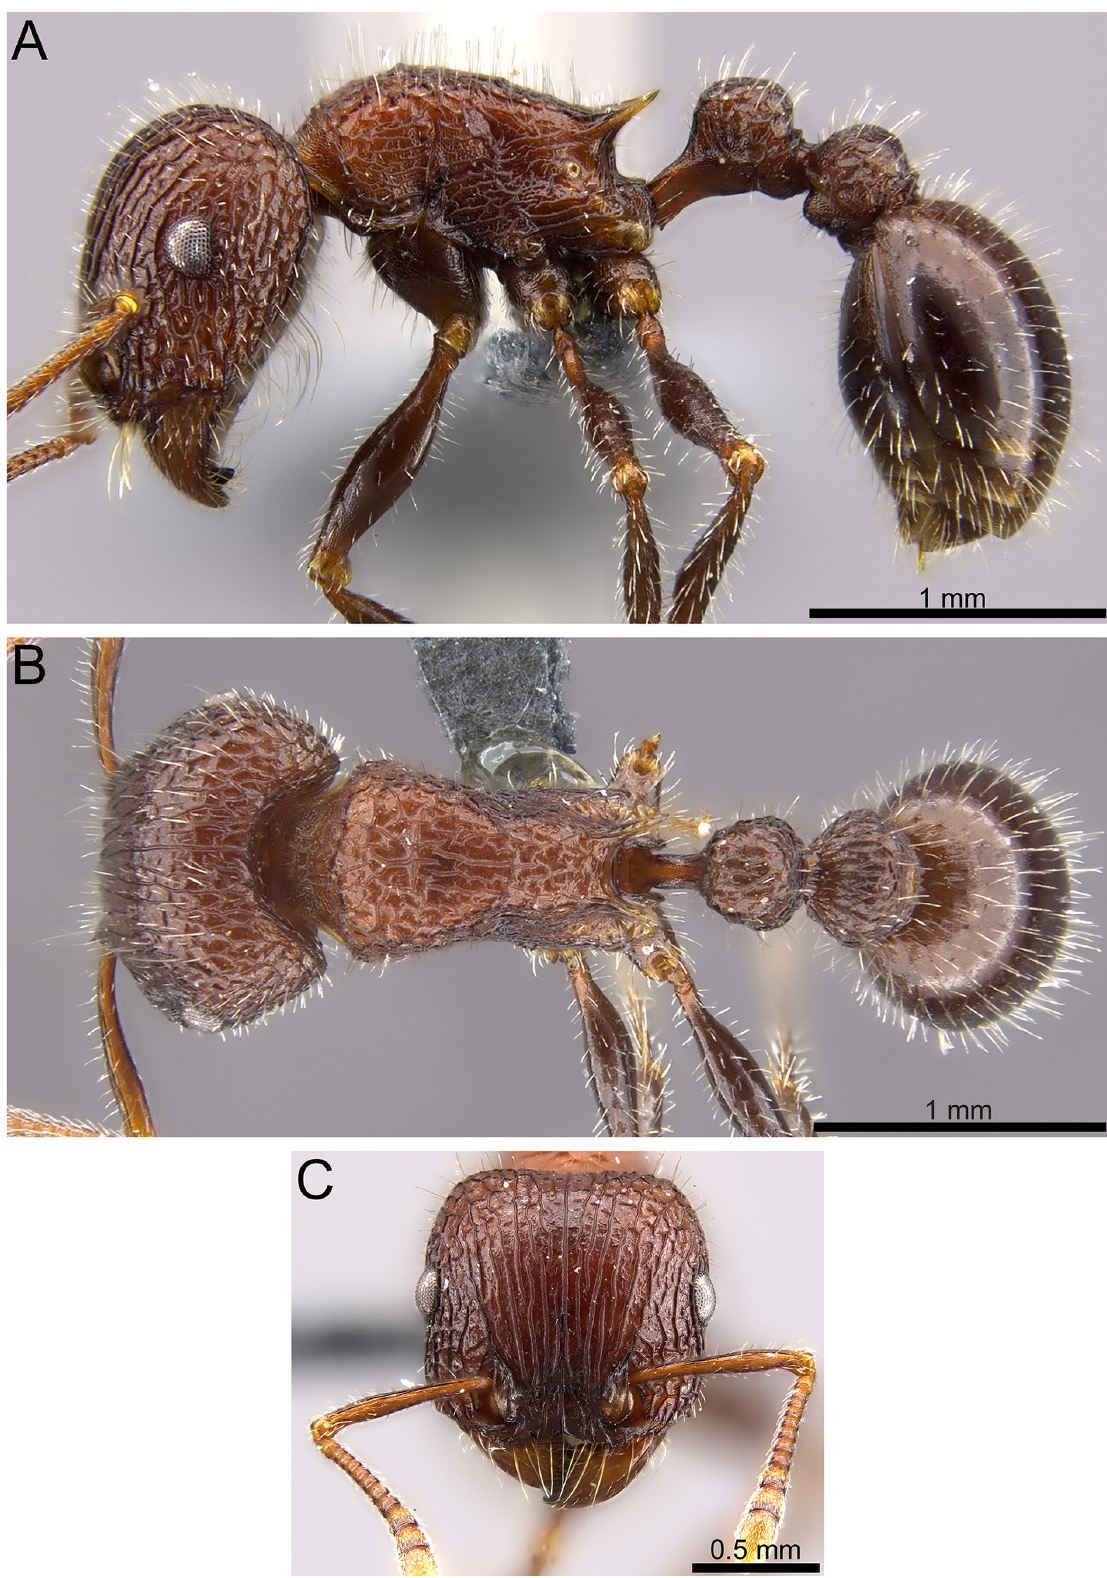
Fig. 17. Tetramorium peringueyi Arnold, 1926 (CASENT0250873). A . Body in profile. B . Body in dorsal view. C . Head in full-face